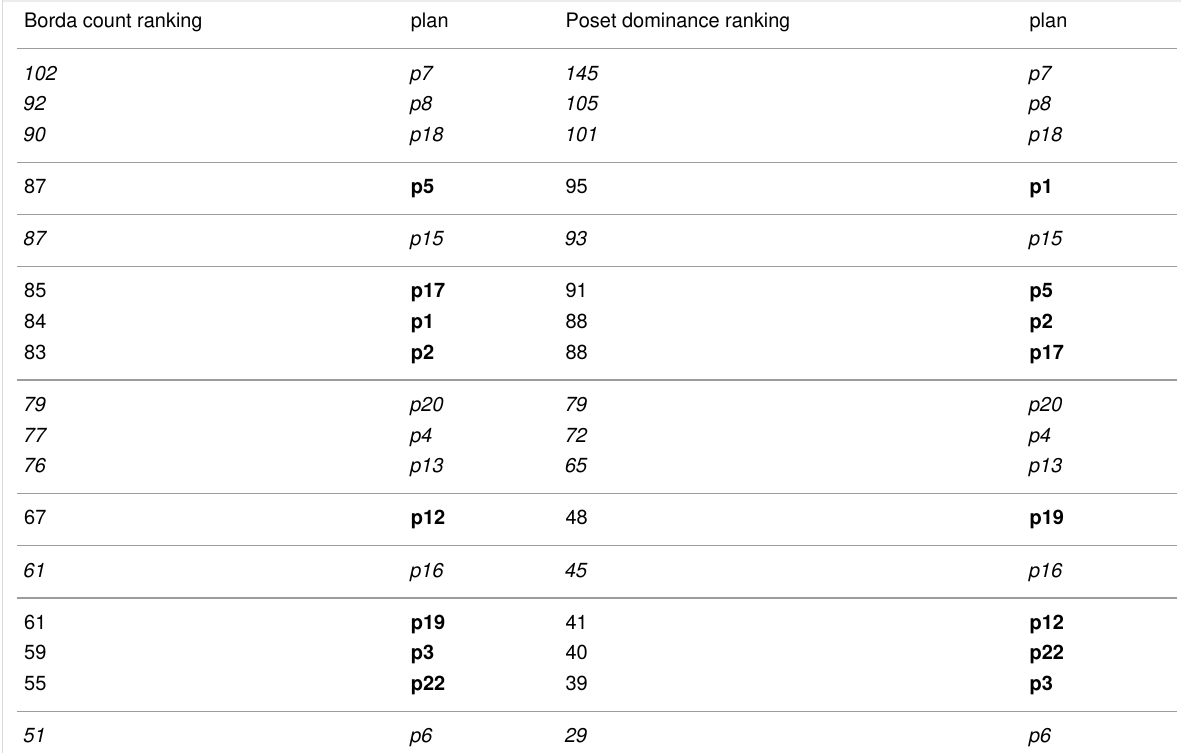
Table 7: Summary of Borda count and poset dominance rankings of 22 synthesis plans for vanillin. a,b Borda count